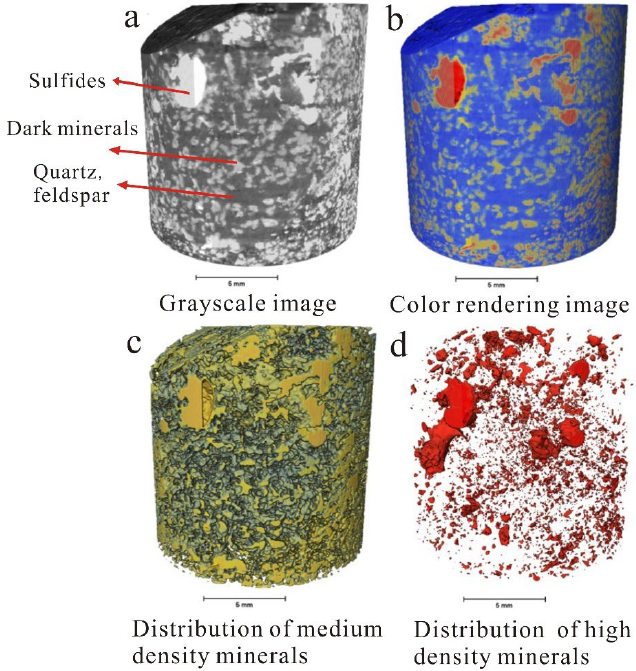
Figure 4. 3D sketch images of the drill core from the Huangyangshan graphite deposit; ( a ) grayscale image; ( b ) color rendering image; ( c ) distribution of medium density minerals; ( d ) distribution of high density minerals.